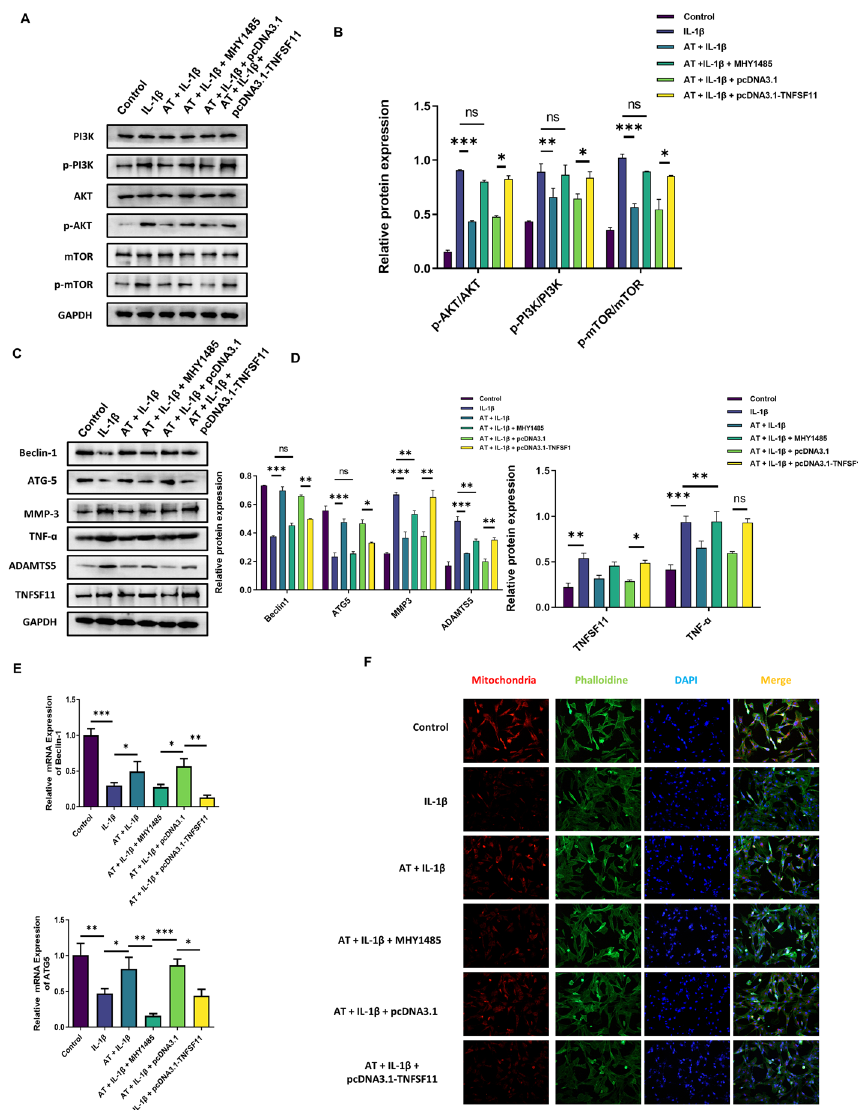
Fig. 5 AT relieved osteoarthritis by activating autophagy through reducing TNFSF11 expression. A Western blot was used to analyze the proteins of the PI3K/AKT/mTOR signaling pathway, including PI3K, p-PI3K, AKT, p-AKT, mTOR, and p-mTOR. Three experiments were performed. B Protein level of PI3K, p-PI3K, AKT, p-AKT, mTOR, and p-mTOR normalized to GAPDH using ImageJ software. C Western blot was used to analyze the proteins of ATG-5, beclin-1, MMP-3, TNF-α, ADAMTS5, and TNFSF11. D Proteins levels of ATG-5, beclin-1, MMP-3, TNF-α, ADAMTS5, and TNFSF11 normalized to GAPDH using ImageJ software. E Real-time RT-PCR was performed to determine the gene expression of ATG-5 and Beclin-1. F Immunofluorescence staining for mitochondria, Phalloidin was stained for cellular actin, and DAPI was stained for nuclear. Control: without IL-1β; IL-1β group: with 10 ng/mL; IL-1β AT group: with 10 ng/mL IL-1β and 20 μM AT with MHY1485, + pcDNA3.1, and pcDNA3.1- TNFSF11 . G Real-time RT-PCR was performed to determine the gene expression of TNFSF11 . H Real-time RT-PCR was performed to determine the gene expression of MMP-3, TNF-α, and ADAMTS5. All experiments were performed in triplicate. Data represent the mean SD ( n 3), * P < 0.05, ** ± = P < 0.01 and *** P < 0.001 vs. the IL-1β